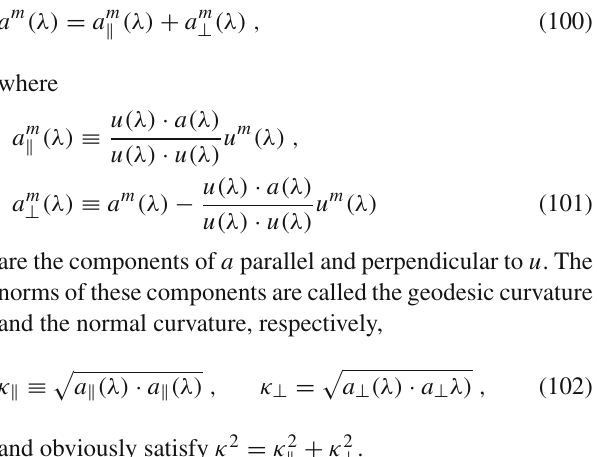
μ (λ) = ( 0 . 3 λ,λ) , ( 2tanh (λ/ 2 ),λ) , c